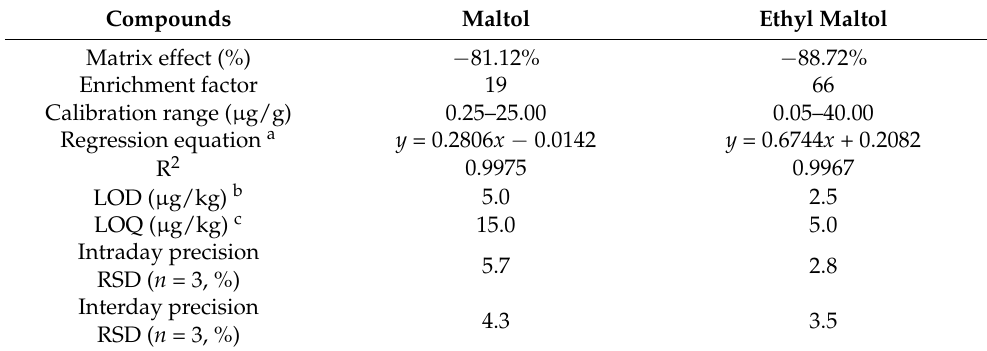
Interday precision a y is the peak area of flavor substances and x is the concentration of flavor substances; b S/N = 3; c S/N =